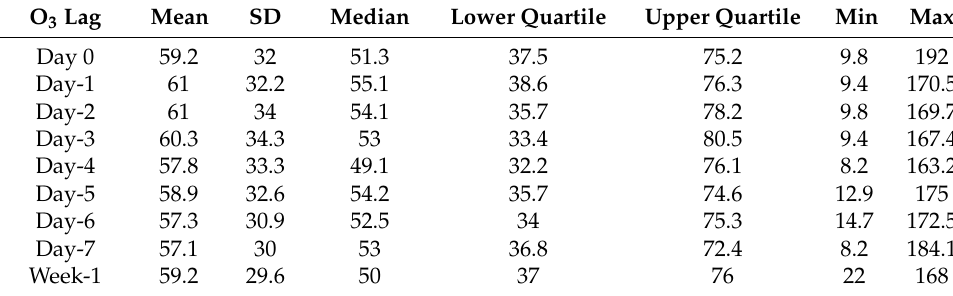
Table A4. O 3 concentrations in the 1 week before the evaluation.